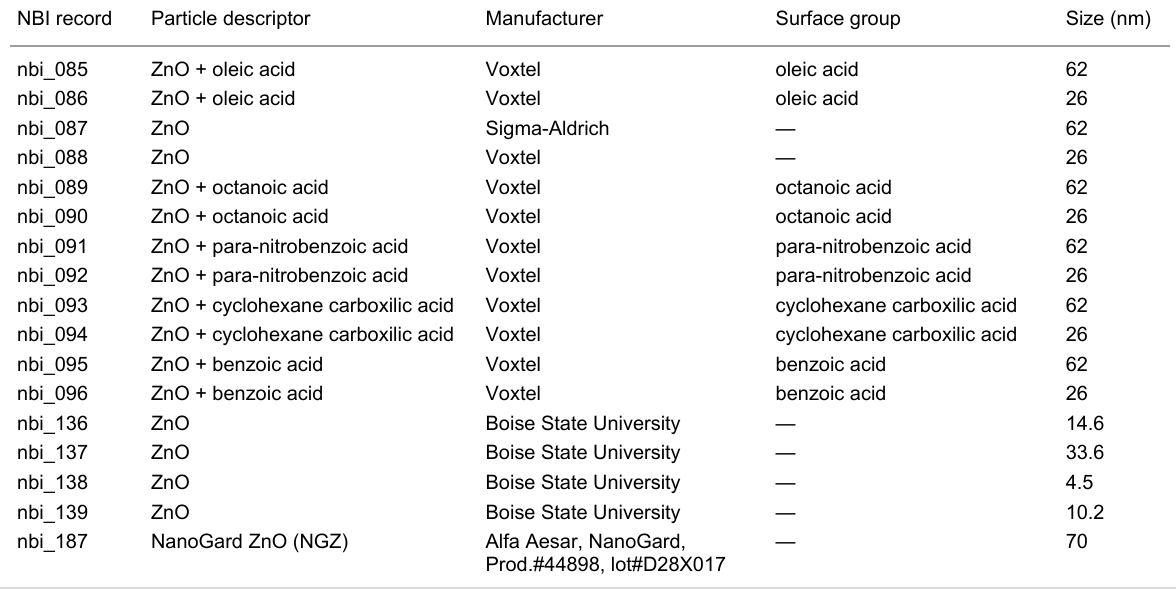
Table 1: Description of zinc oxide nanoparticles included in this study (17 in total). NBI